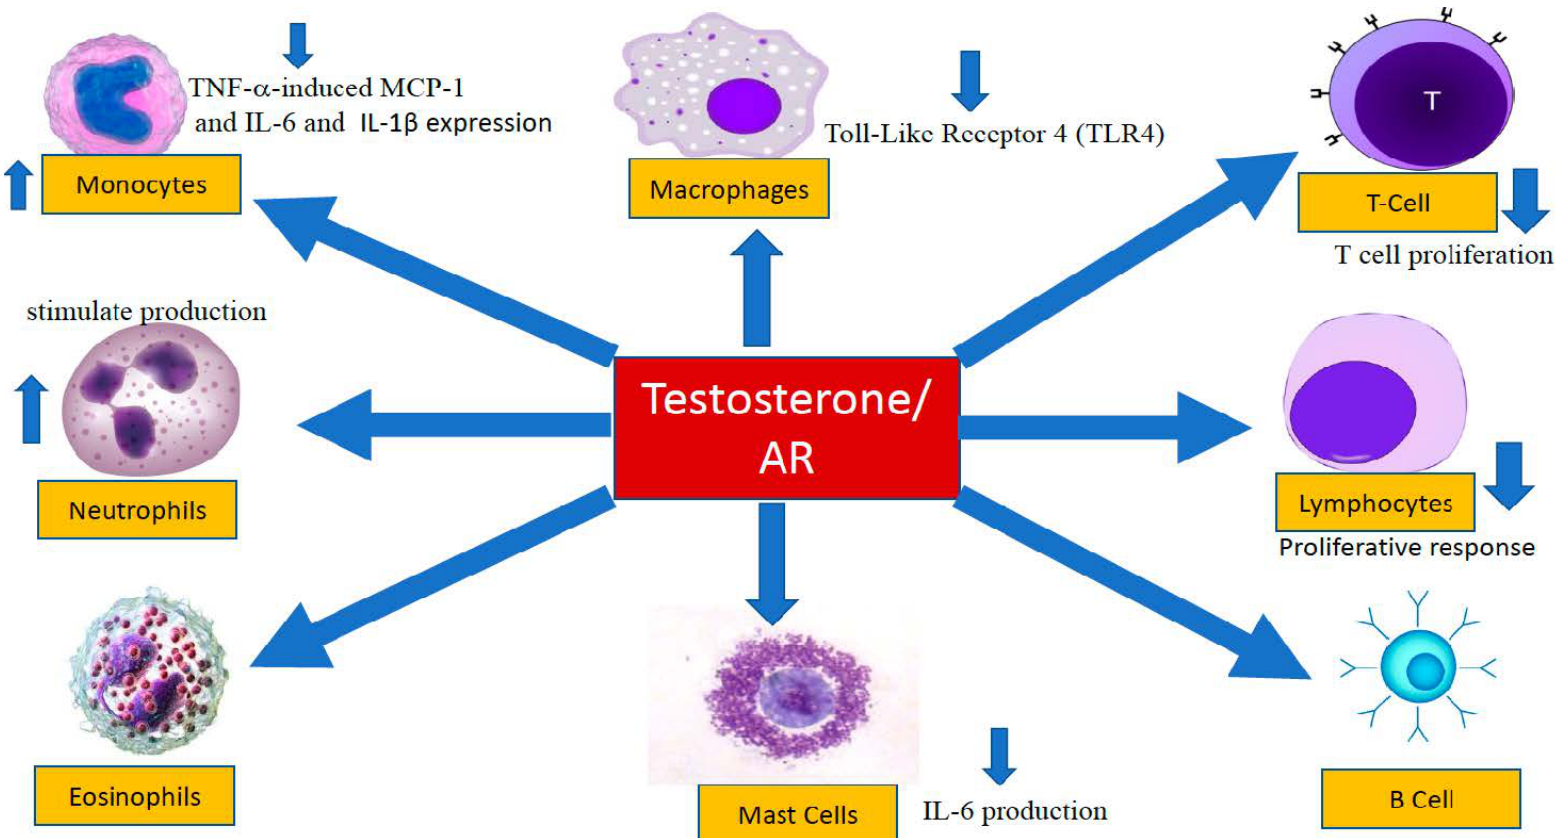
Figure 2. Testosterone modulates the innate and adaptive immune compartments, including monocytes, macrophages, neutrophils, eosinophils, mast cells, lymphocytes, T-cells, and B-cells.